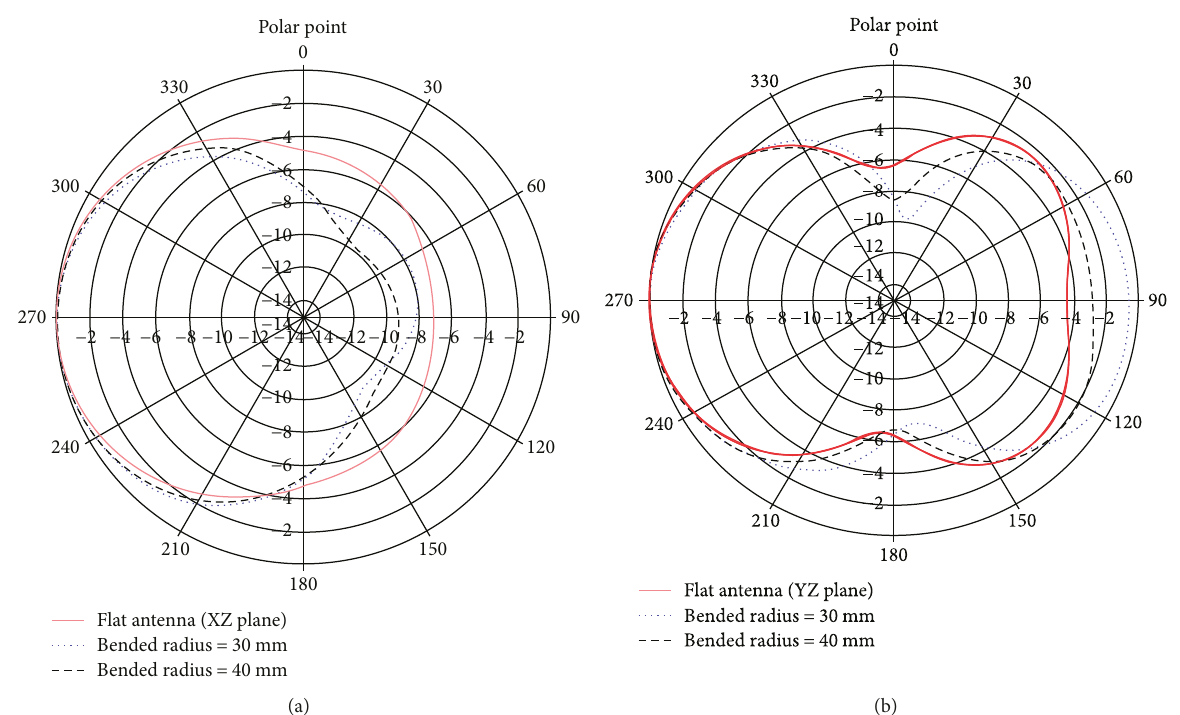
Figure 9: Radiation patterns of the antenna with di ff erent bending radii of 30 and 40 mm: (a) XZ plane ( ϕ =0 ° ) and (b) YZ plane ( ϕ =90 ° ).